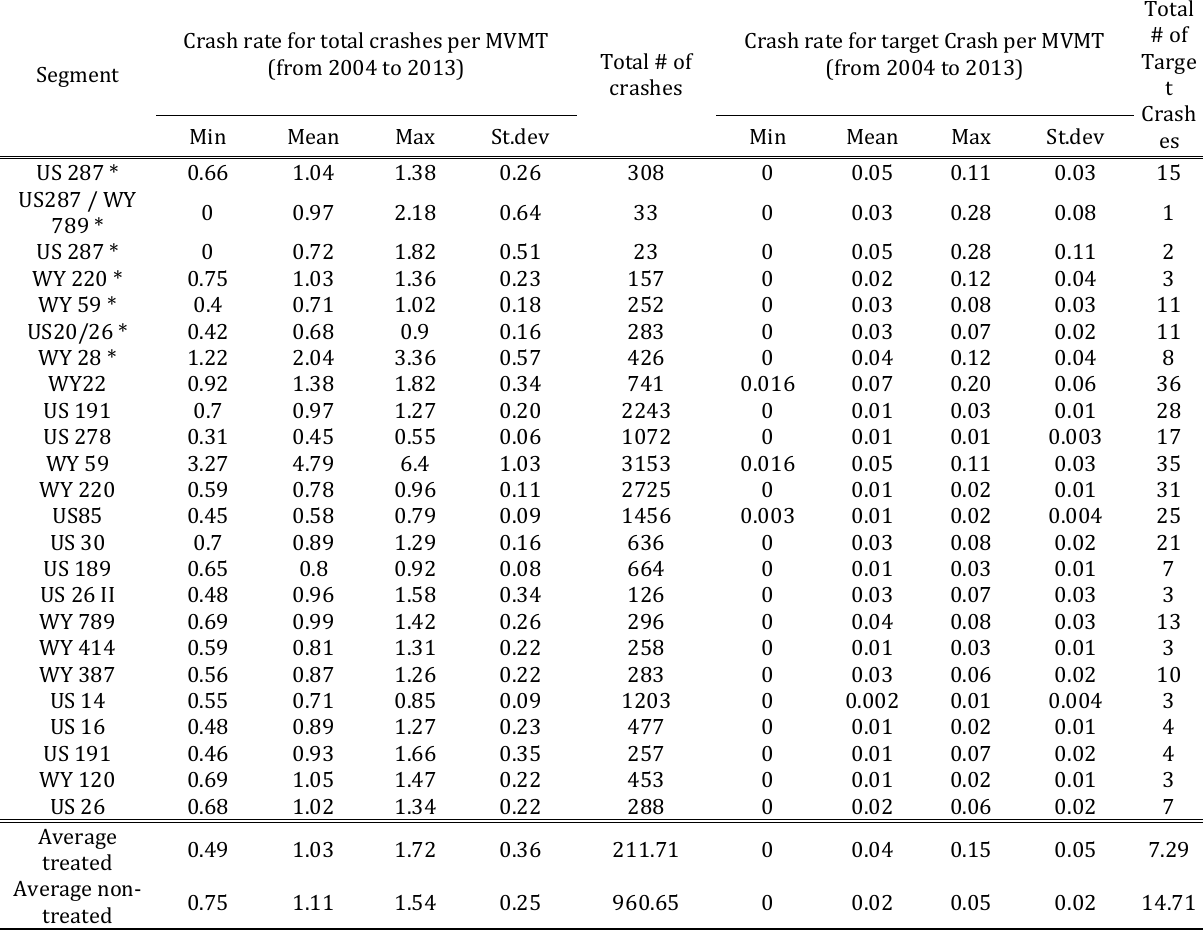
Table 5: Descriptive Statistics of Crash Rates for Headlight and Non-Headlight Sign Sections